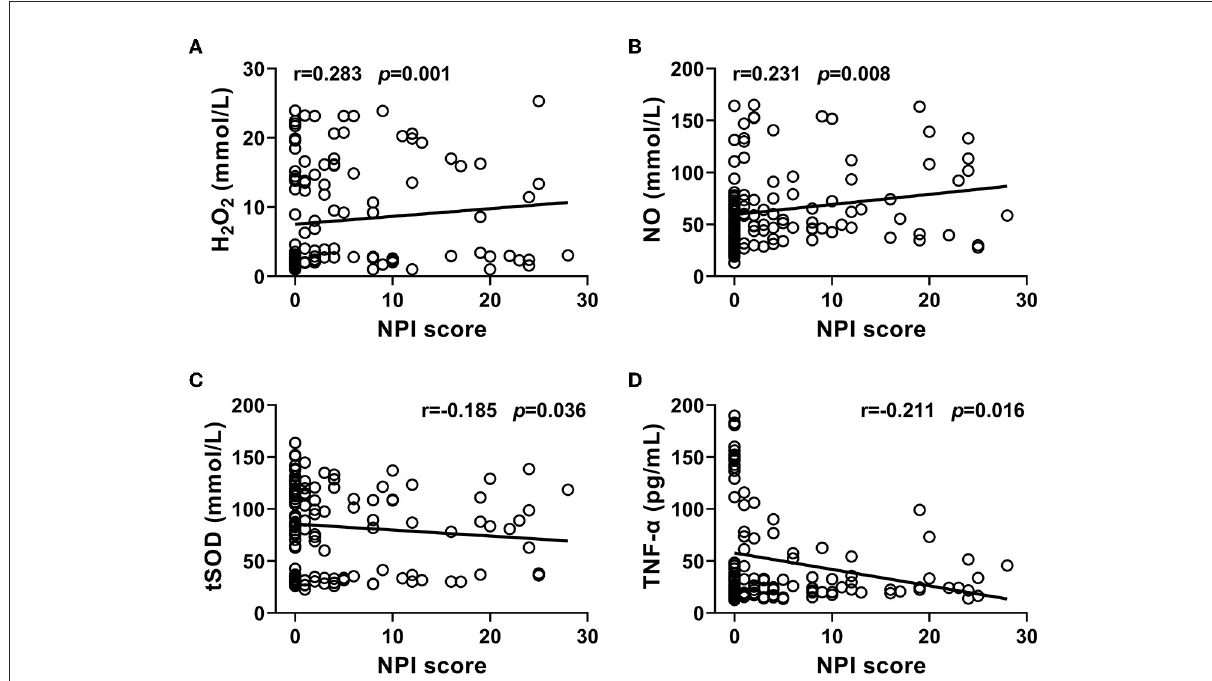
FIGURE2 (A–D) Correlations of NPI score with the levels of H 2 O 2 , NO, and TNF- α , and the activity of tSOD in CSF from PD patients were analyzed. The results indicated that NPI score significantly and positively correlated with the levels of H 2 O 2 and NO, and negatively correlated with the activity of tSOD and the level of TNF- α in CSF from PD